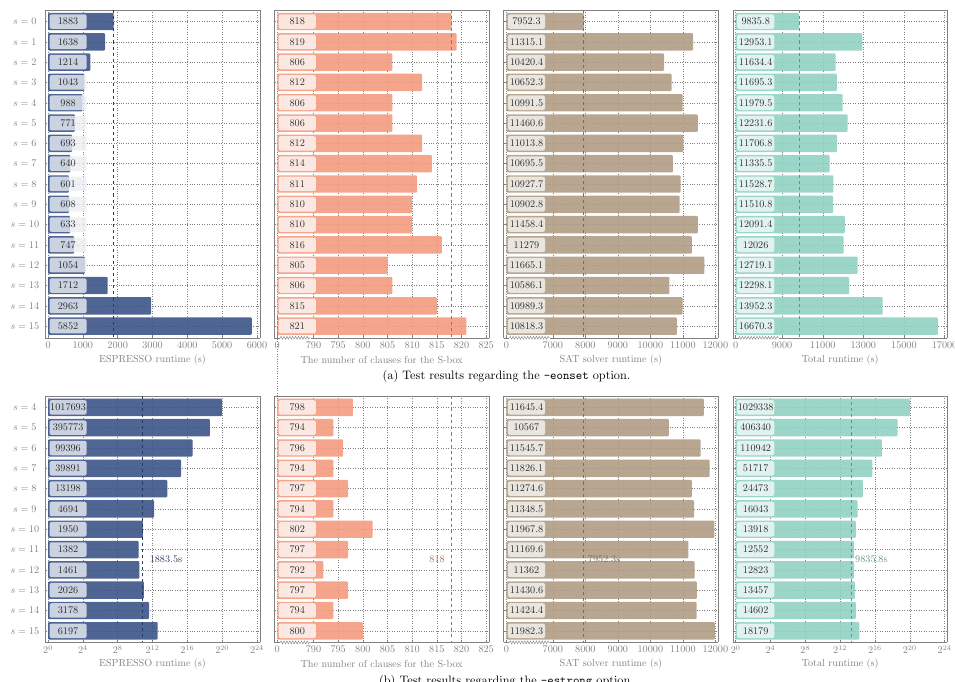
Figure 3: Iterative simplification for the 25-bit Boolean function f